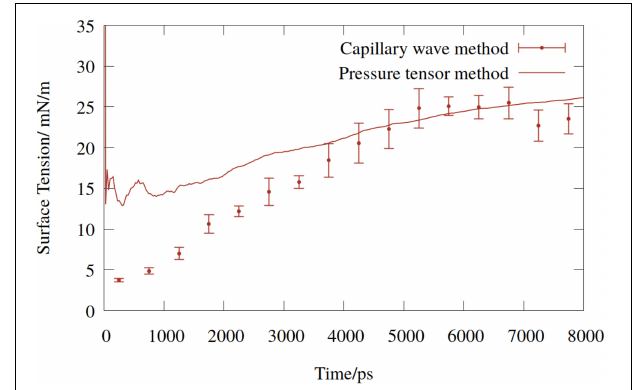
FIGURE 3 | Time dependent surface tension of digalactosyldiacylglycerol (DGDG) monolayers (mean of upper and lower) pulled at a pressure of − 1.5 MPa. Solid line represents the cumulative average of the pressure tensor estimate, points represent the capillary wave